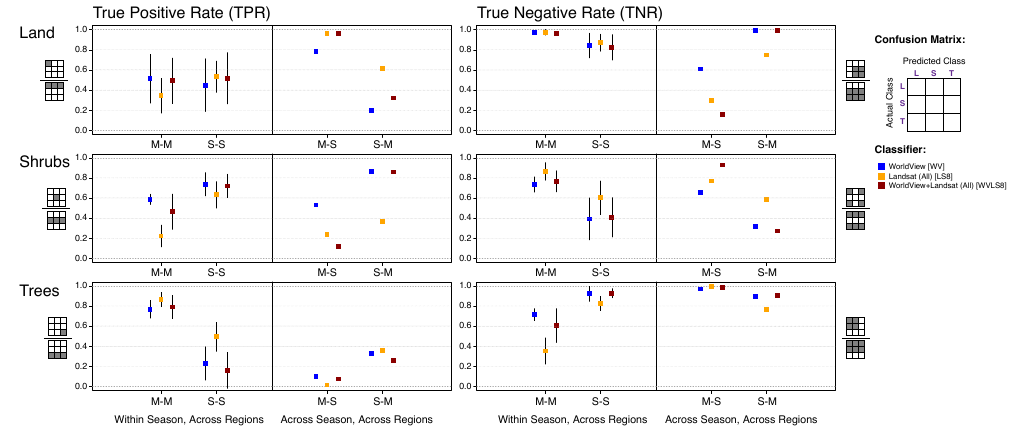
Figure 5. Spatial (cross-region) and seasonal cross-validation: TPR and TNR are shown for ( top row ) land, ( middle row ) shrubs, and ( bottom row ) trees. In each plot, the points to the left of the center line show the results from within-season classification, with 95% CI calculated across folds; the points to the right of the center line show across-season results. The month label for the across-season results indicates the training set; i.e., “M-M” means that the labeled examples from regions imaged in March were used to classify the other March regions; “S” indicates September. There are no error bars for the cross-season experiment as, for this, all of the data from one season was used to classify the